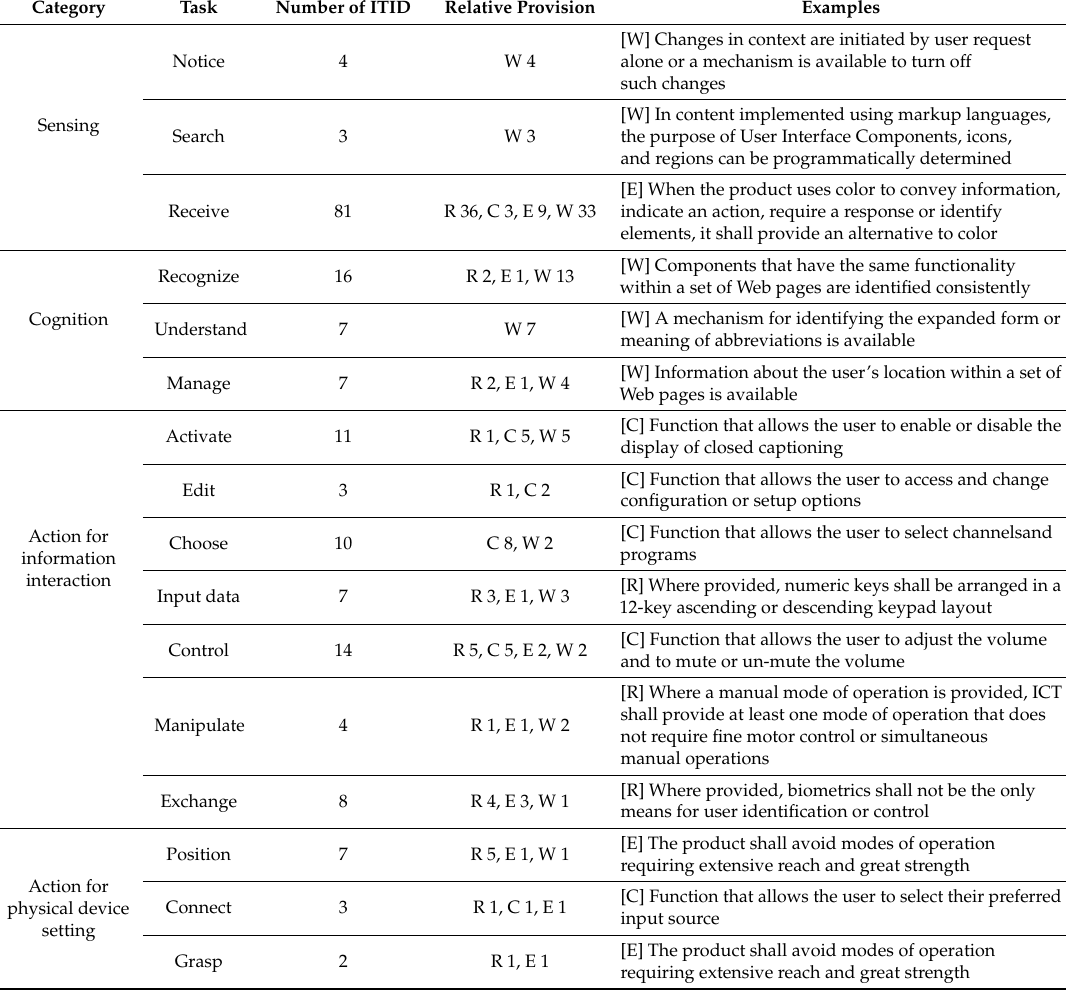
Table 7. Numbers of provisions for each task.